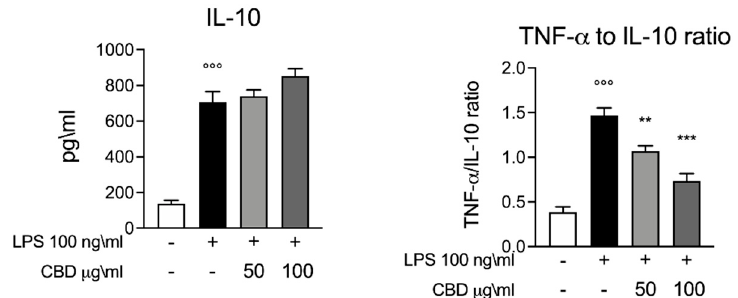
Figure 2. ELISA assay for IL-10. Left panel, whole blood culture supernatant 24 h after LPS 100 ng/mL stimulation. Right panel, TNF- α to IL-10 ratio graph calculated based on the results of the ELISA assay. Data are presented as means ± SEM for each group. ◦◦◦ p < 0.01 vs. control; ** p < 0.01 vs. LPS; *** p < 0.001 vs. LPS.